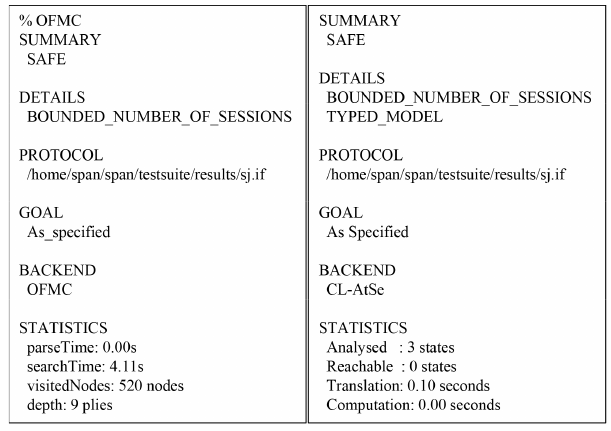
Figure 11. AVISPA simulation results using On-the-Fly Model Checker (OFMC) and Constraint-Logic-based ATtack SEarcher